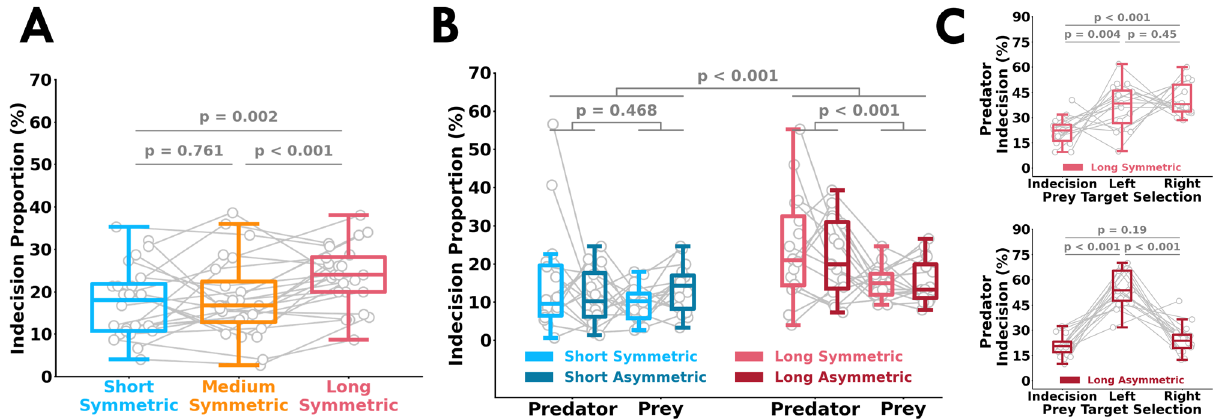
Figure 7. Indecisive behaviour. Proportion of trials ( y-axis ) where participants did not select a target for each condition in ( A ) Experiment 1 and ( B ) Experiment 2. The open gray circles and connecting gray lines correspond to individual participants. Box plots show 25th, 50th, and 75th percentiles. Across both experiments, there were a greater proportion of trials where the participants did not select a target ( y-axis ) in the long conditions relative to the other conditions. Participants did not select a target in the short trial conditions if they did not react in time to the first beep or reach at the necessary speed. Conversely, participants had sufficient time to select a target in the long conditions. More indecisions with more available time may reflect a ‘paralysis- by-analysis’ phenomenon. That is, indecisions may have arisen from participants waiting too long to acquire sensory evidence of their opponent’s intended target selection. Additionally, the predator had higher proportions of indecisions in comparison to the prey in the long conditions. ( C ) Predator indecision proportions ( y-axis ) depending upon the Prey’s target selection or indecision ( x-axis ). In the long-symmetric condition, there was no difference in predator indecision proportions when the prey selected the right or left targets. Conversely, in the long-asymmetric condition the predator had significantly greater indecisions when the prey selected the left target compared to the right target. These results suggest that indecisive behaviour is also influenced by the reward